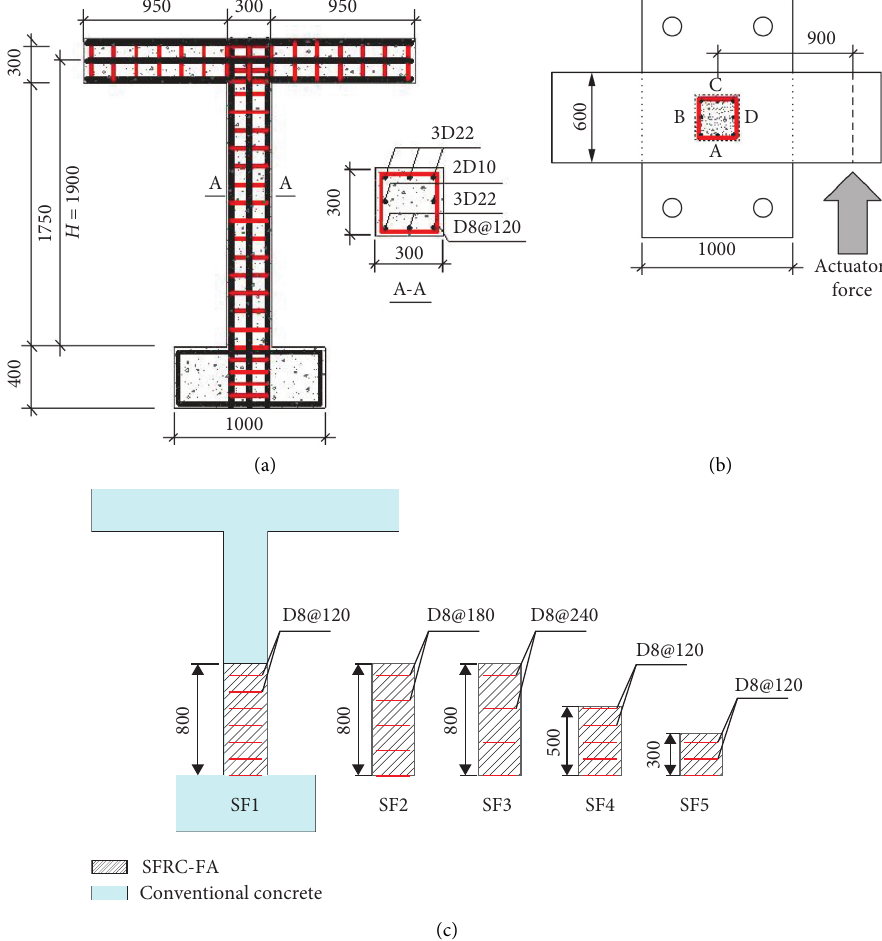
Figure 1: Specimen configuration. (a) C1 specimen. (b) Top view of specimen. (c) SF1 ∼ SF5 specimens. Table 1: Parameters of the specimens on replacement region. Column